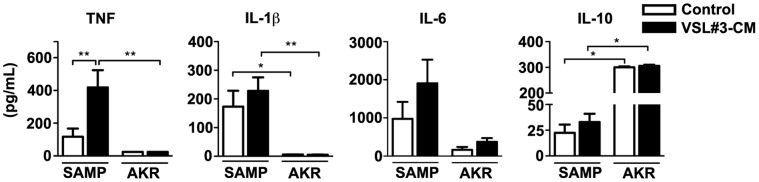
Increased ileal innate-type cytokine secretion following VSL3# treatment.Supernatants were collected from cultured ilea that were exposed apically to VSL#3-CM and cytokine protein levels measured as described in Methods and Materials. *p<0.05 and **p<0.01 vs. vehicle control or age- and treatment-matched AKR. Results are representative of two independent experiments (N = 6/exp grp) and expressed as mean ± SEM.